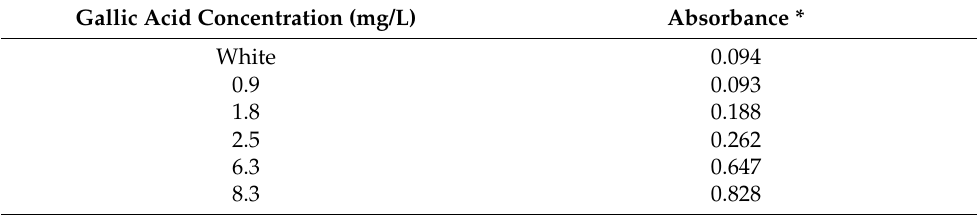
Table A1. Calibration curve for phenolic